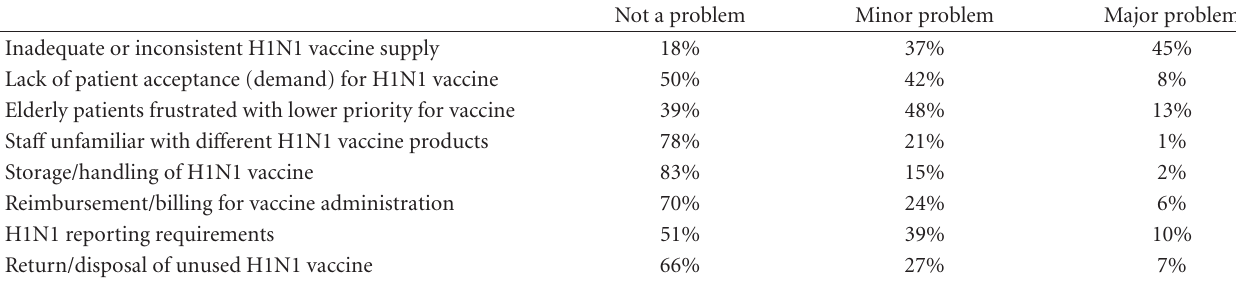
Table 4: Extent of problems experienced by pulmonologists providing H1N1 vaccine ( N =